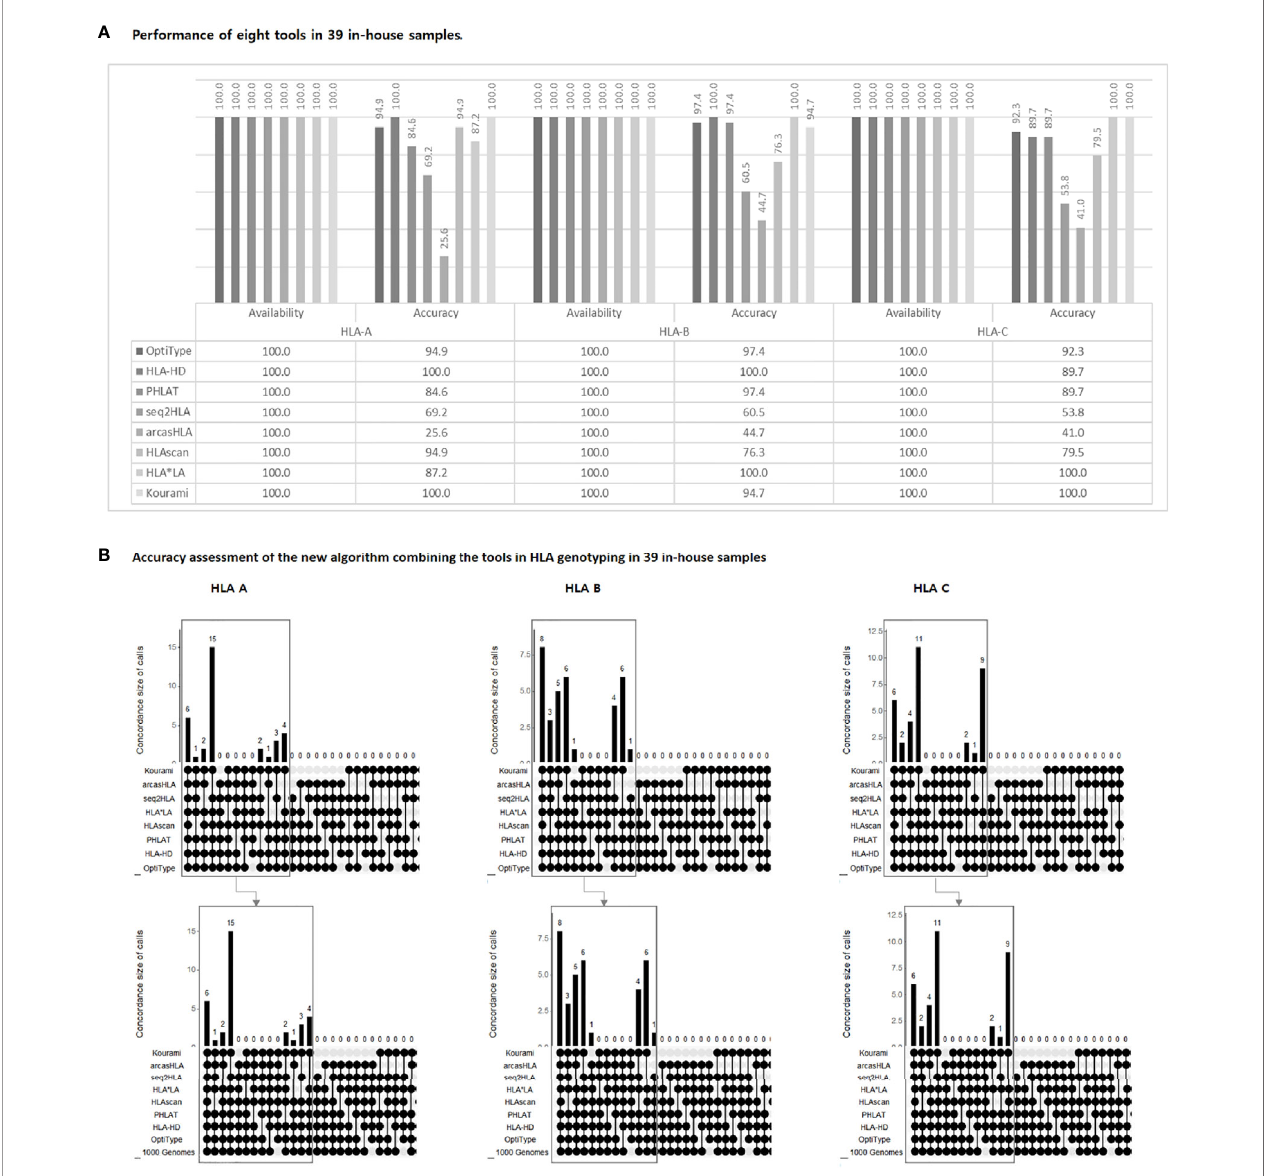
four categories: two-digit resolution for allele group, four-digit resolution for speci fi c HLA protein, six-digit resolution for speci fi c HLA coding sequence, and eight-digit resolution for speci fi c HLA genome sequence, including introns and untranslated regions